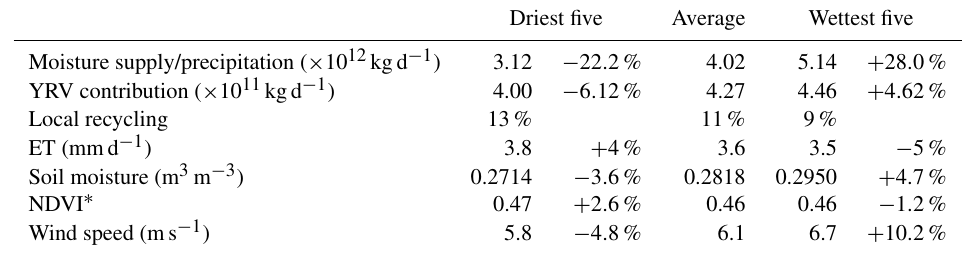
Table 3. Local variables for the five driest (1981, 1985, 2003, 2006, 2013) and wettest (1993, 1995, 1996, 1998, 1999) YRV